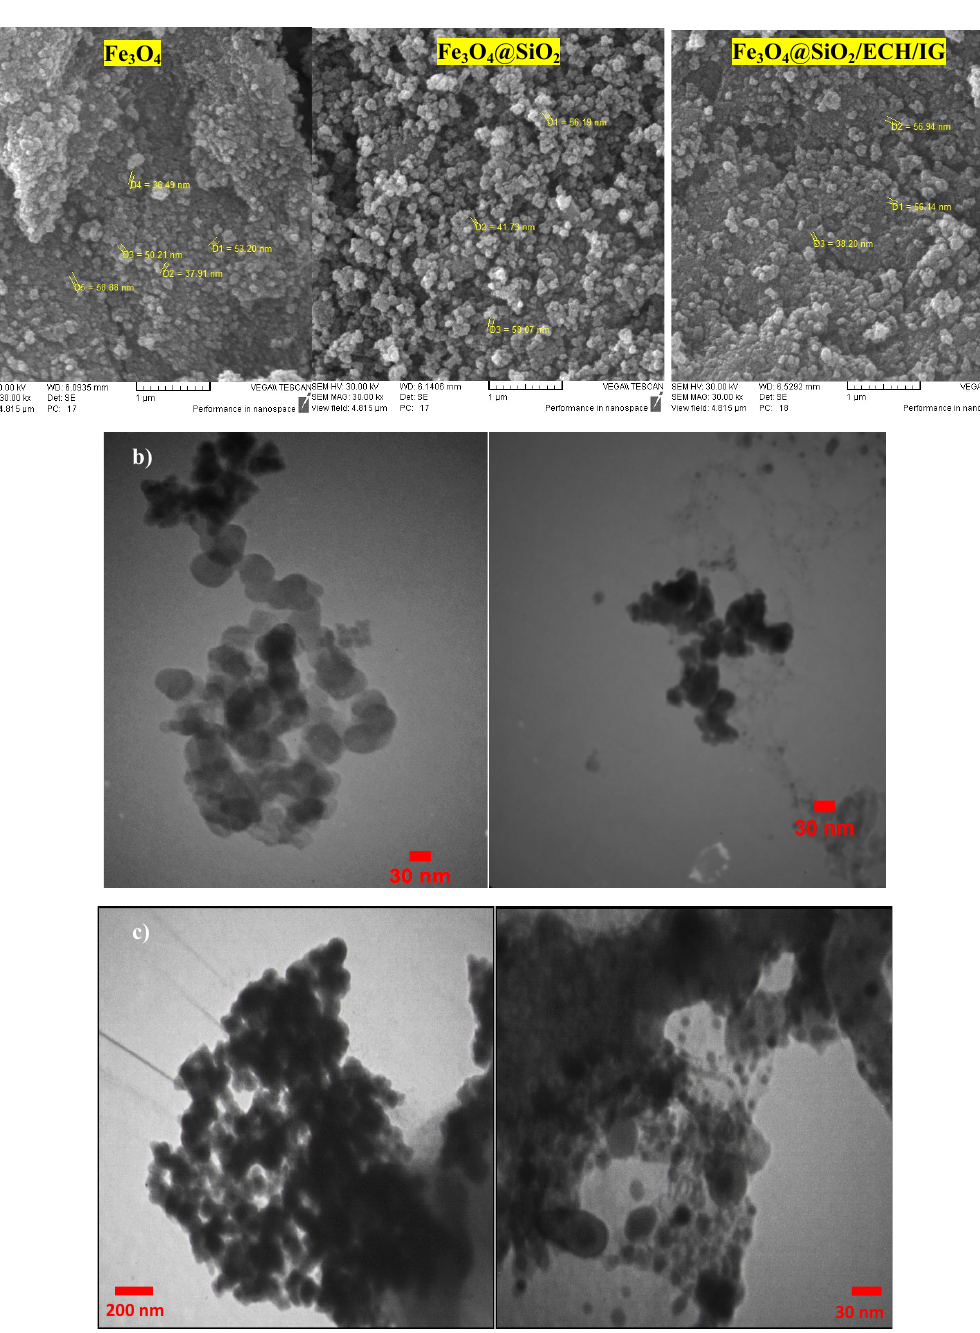
Figure 4. ( a ) SEM images of Fe 3 O 4 , Fe 3 O 4 @SiO 2 and Fe 3 O 4 @SiO 2 /ECH/IG and ( b ) TEM images of Fe 3 O 4 @